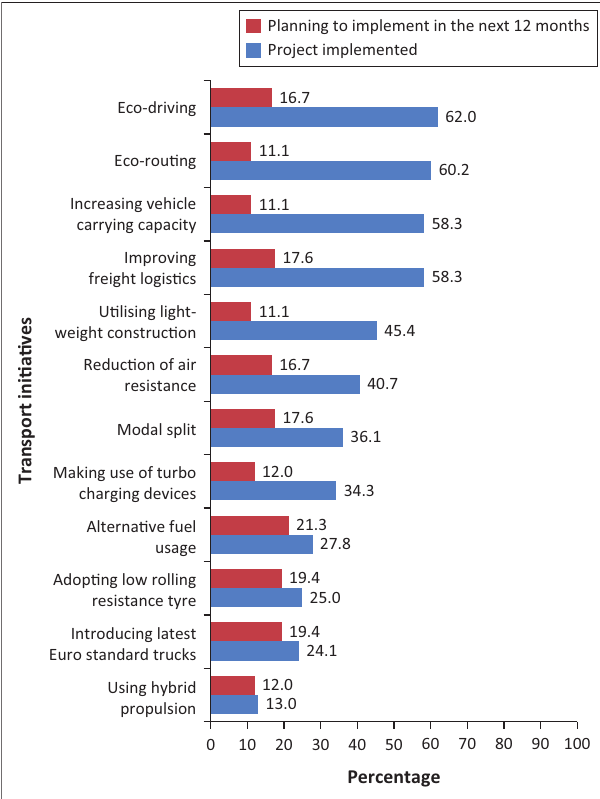
FIGURE 3: Sustainable transport